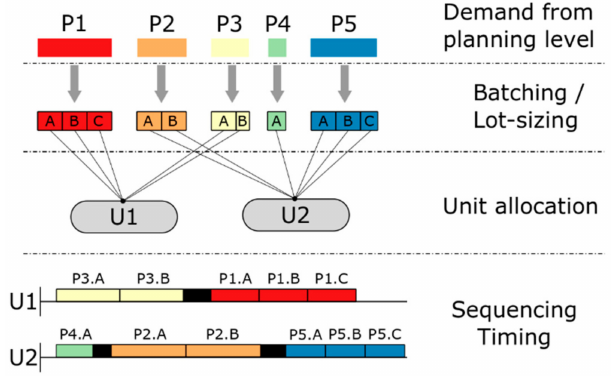
Figure 1. Decisions of production scheduling in the process industries.